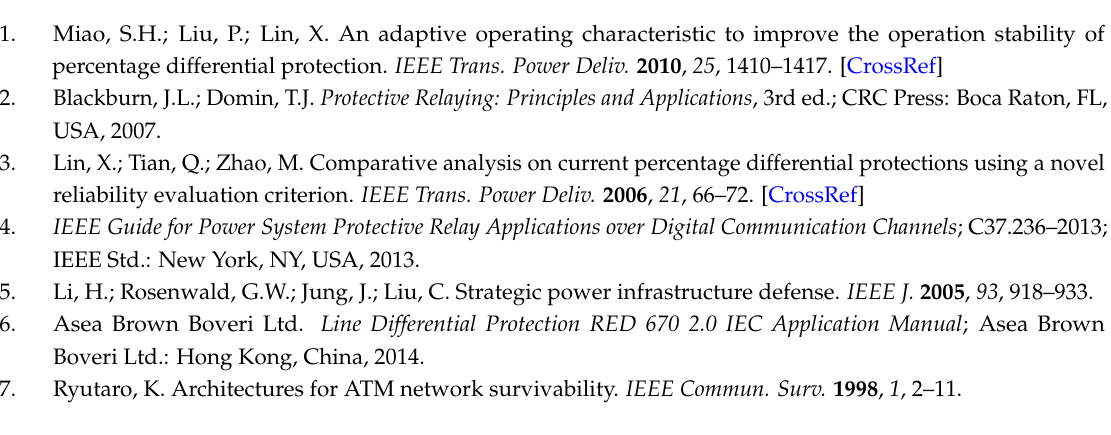
Figure 12. Differential current of each phase and the trip signal (single-phase-to-ground fault happens at 0.16 s).